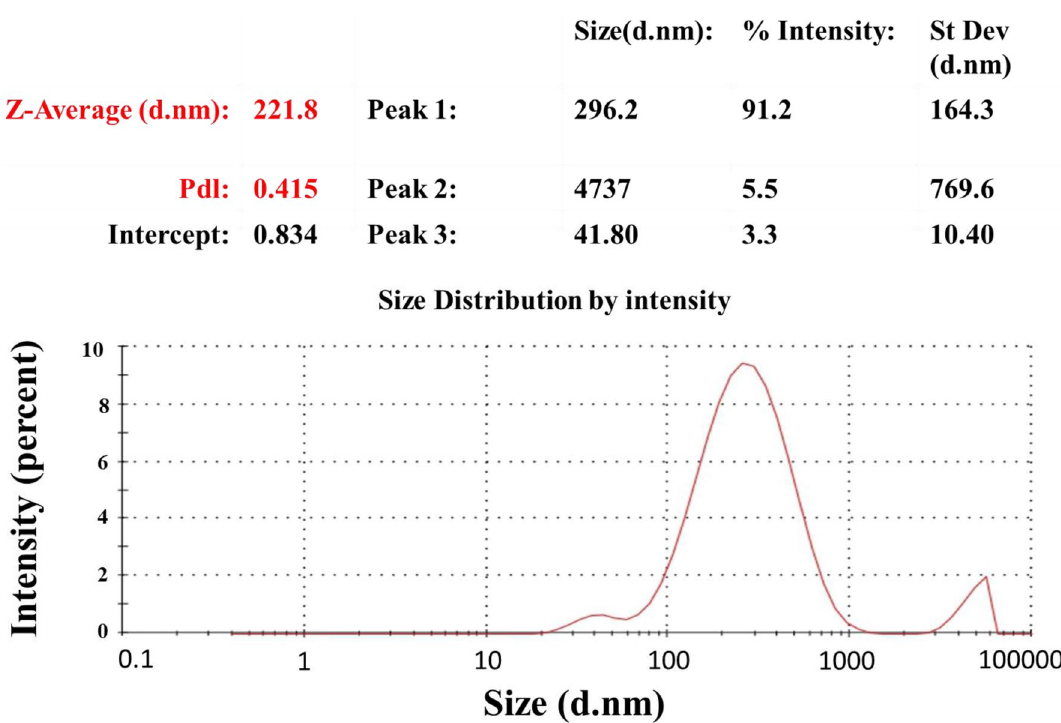
Figure 11. Dynamic light scattering of Ag